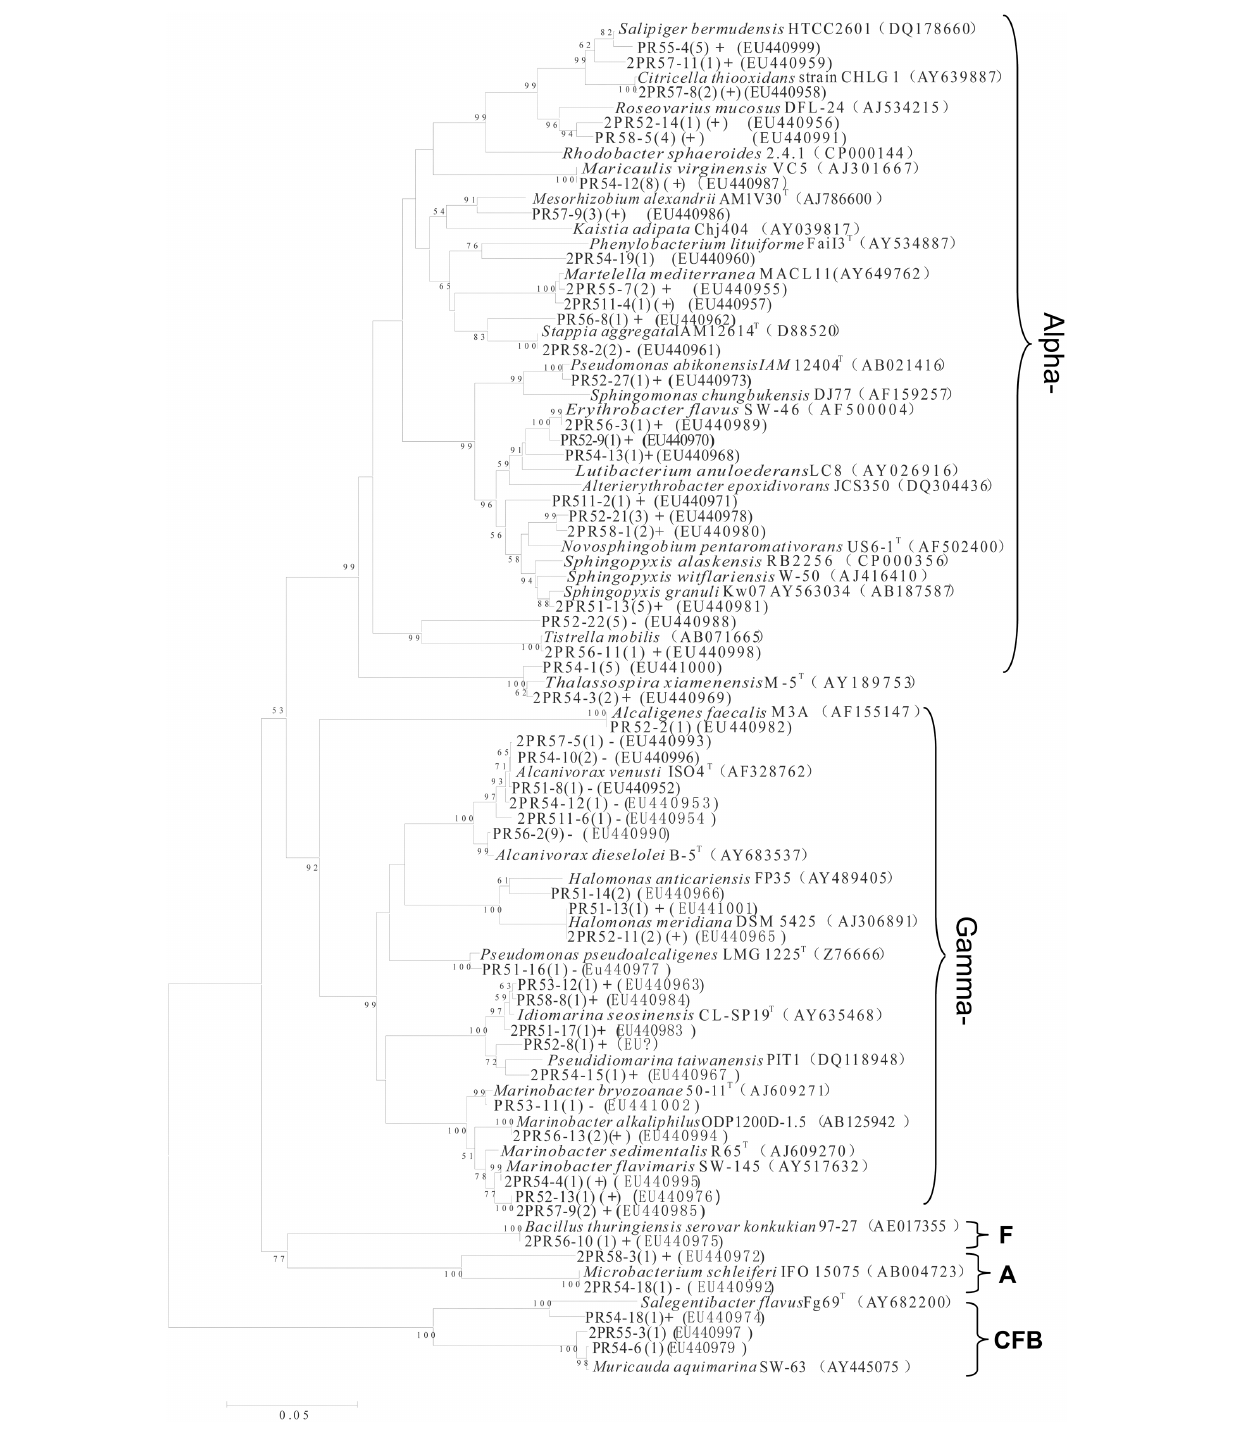
FIGURE 3 | Phylogenetic tree of culturable strains isolated from the nine PAH-degrading bacterial consortia. The dendrogram was constructed from a matrix by the neighbor-joining method using the MEGA3.1 program. Thousands of trial bootstrap analysis was used to provide confident estimates for phylogenetic tree topologies. The scale bar represented 0.05 substitutions per nucleotide site. The number in the bracket shows the frequency with which the bacterium appeared in the nine PAH-degrading